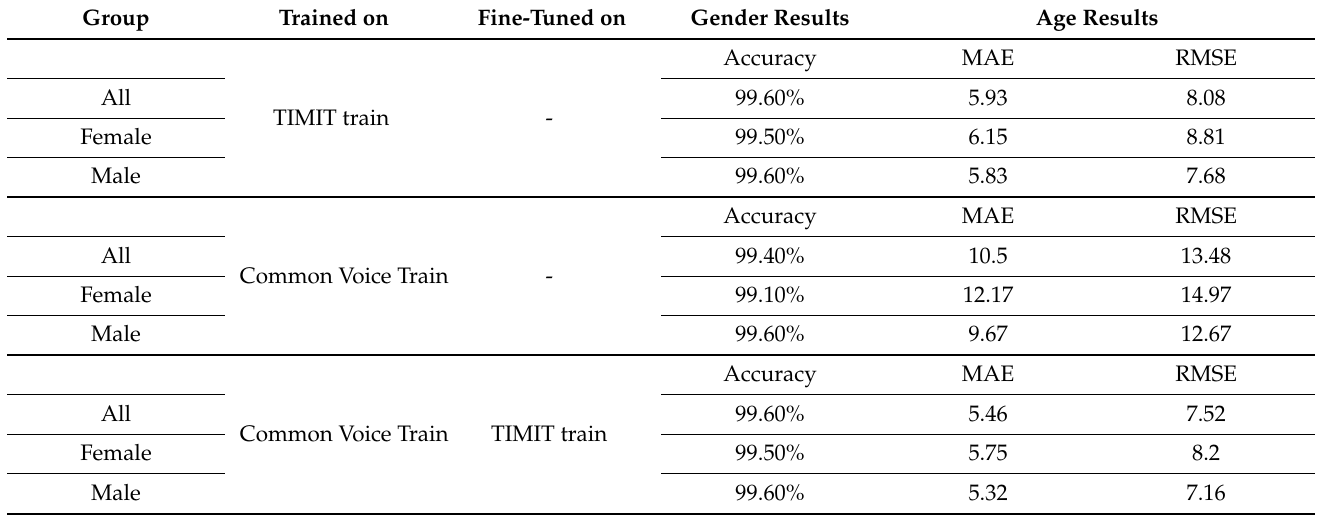
Table 10. Results on the TIMIT test dataset with a pre-trained d-vector embedder as features source. Group